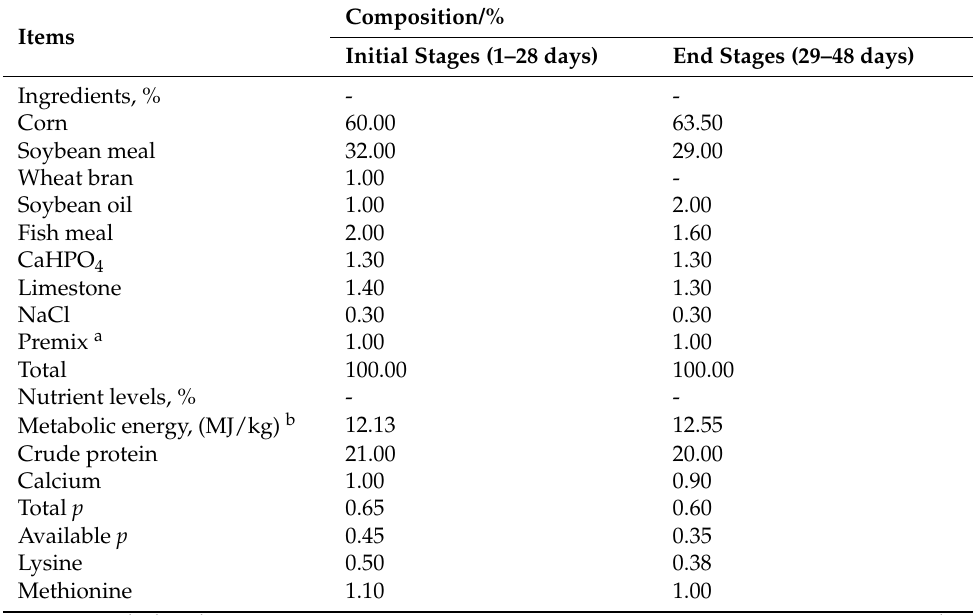
Table 1. Ingredient and nutrient levels of the basal diet in each feeding phase for broilers.